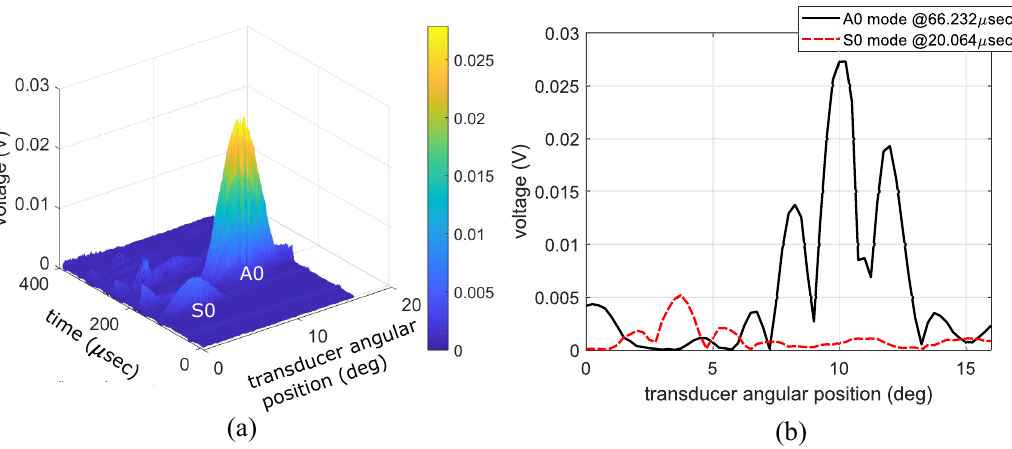
Figure 5. ( a ) Surface plot of the absolute value of the A-scan with respect to the angular positioning of the receiving air-coupled transducer; and ( b ) slices of the surface plot in ( a ) at specific times to highlight and compare the peaks of the S0 and A0